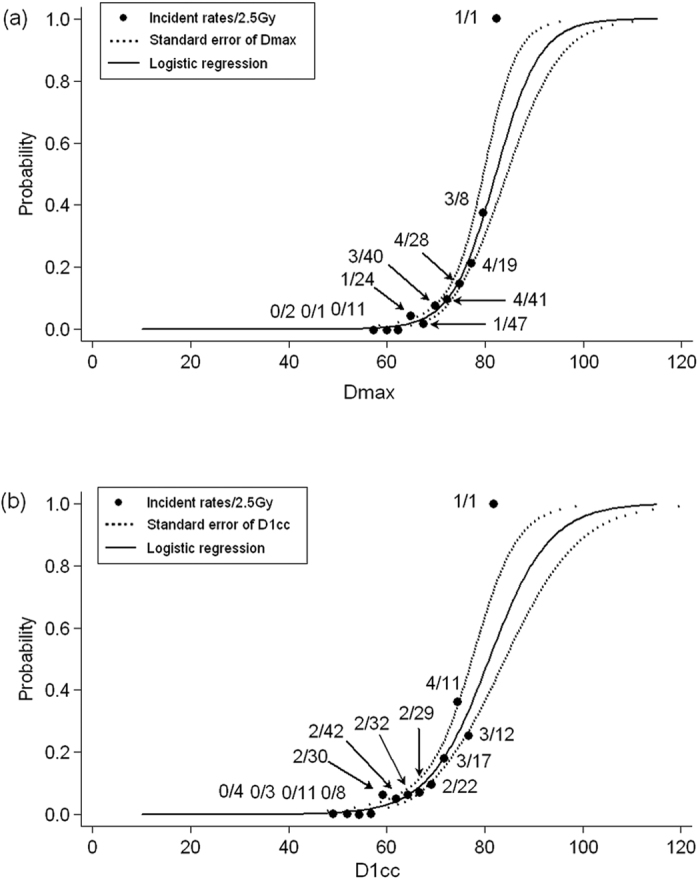
Dose effect curves using a logistic model (n = 222) (a) for variable Dmax and (b) variable D1cc. Dotted lines indicate the single standard error of the tolerance dose at discrete probabilities of 0.01 to 0.99.